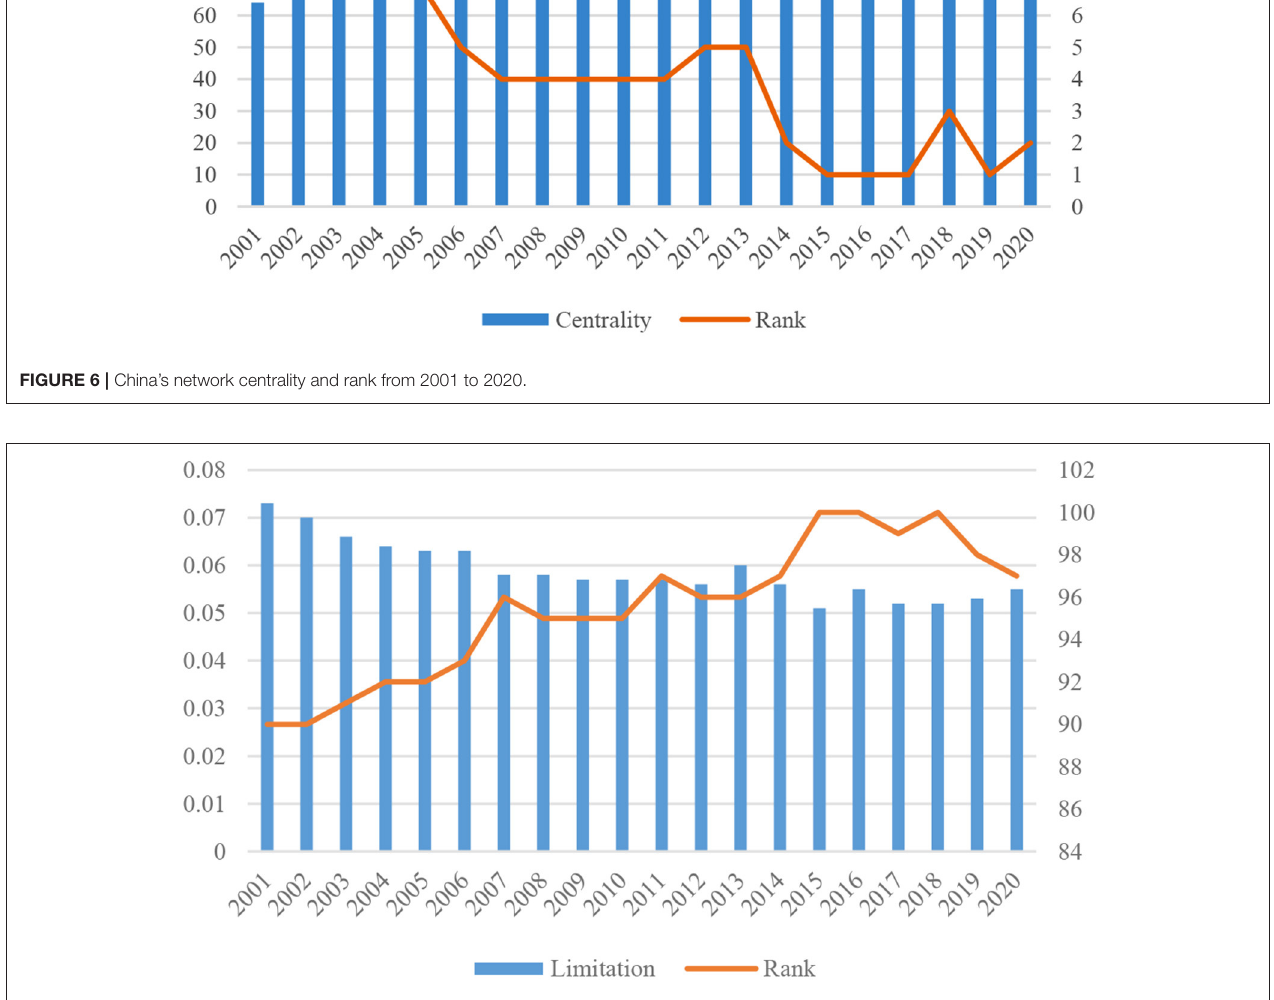
FIGURE 7 | China’s structural hole index and rank in